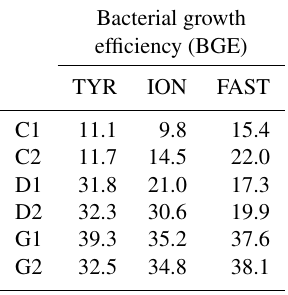
Table 2. Heterotrophic bacterial production (BP) growth rates ( µ BP Table 3. Estimated bacterial growth efficiency (BGE in %) during in h − 1 ) estimated from the exponential phase of BP growth, observ- the course of the three experiments (TYR, ION and FAST) in the six able from at least four sampling points, between t 0 and t 12h, during tanks (controls: C1, C2; dust addition under present conditions of the three experiments (TYR, ION and FAST) in the six tanks (con- temperature and pH: D1, D2; dust addition under future conditions trols: C1, C2; dust addition under present conditions of temperature of temperature and pH: G1 and G2). BGE was calculated based and pH: D1, D2; dust addition under future conditions of tempera- on integrated heterotrophic bacterial production (BP) and commu- ture and pH: G1 and G2). Values ± SE are shown. nity respiration (CR) rates by applying a bacterial respiration to a CR ratio of 0.7 and a respiratory quotient of 0.8 (see Material and µ BP TYR ION FAST